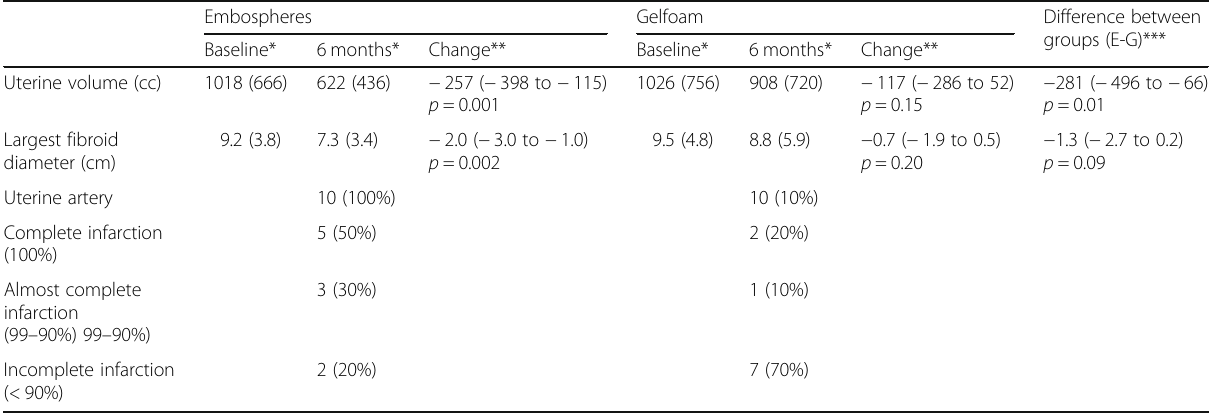
Table 6 Effect of embolic agent on uterine volume, diameter of largest fibroid, infarction rate and uterine artery